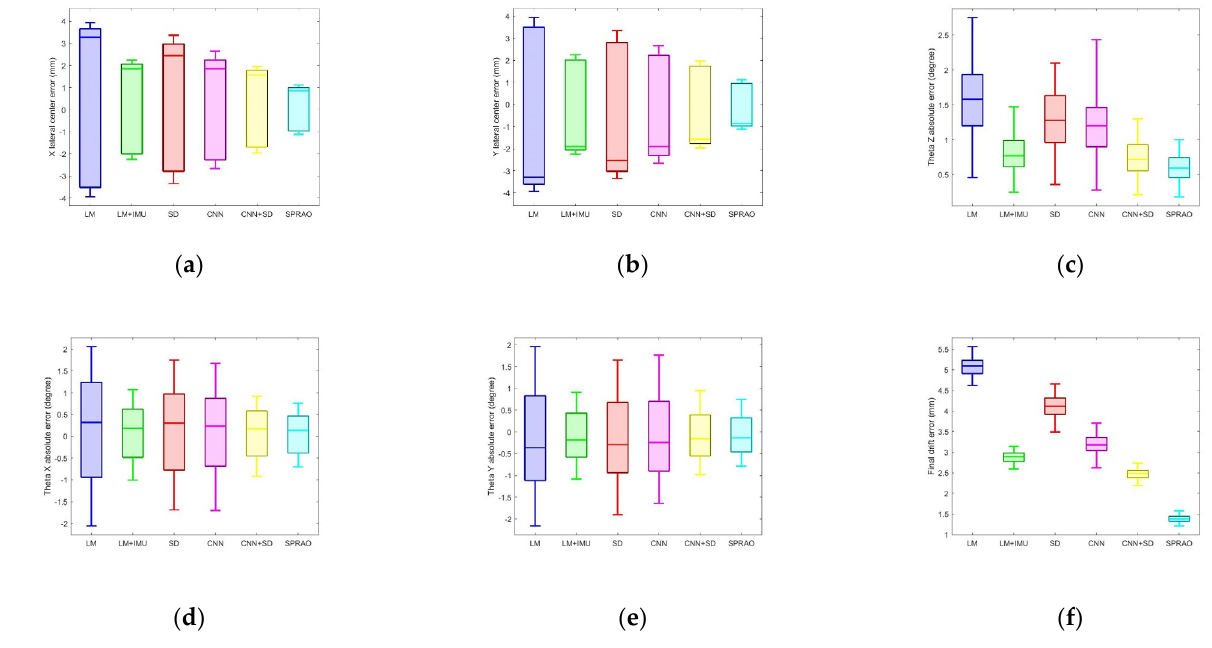
Figure 22. Error of different methods for dataset DB3. ( a ) Theta X; ( b ) Theta Y; ( c ) Theta Z; ( d ) Lateral X; ( e ) Lateral Y; ( f ) Drift.